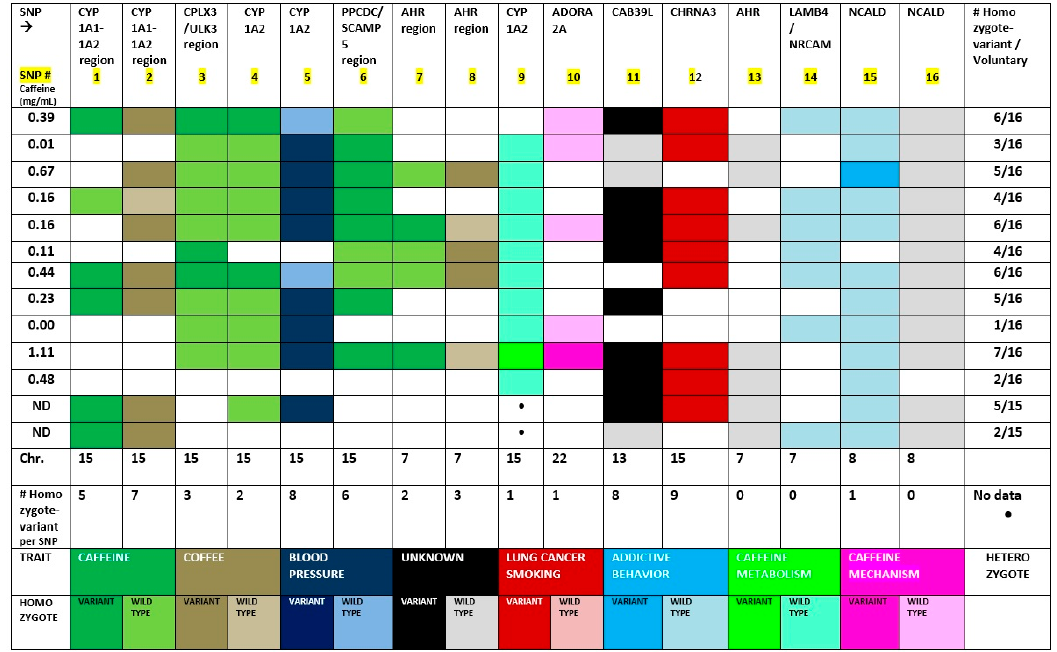
Figure 1. Genotypogram of co ff ee and ca ff eine consumption and related traits: 16 SNPs localized at five chromosomes, genotyped from 13 healthy